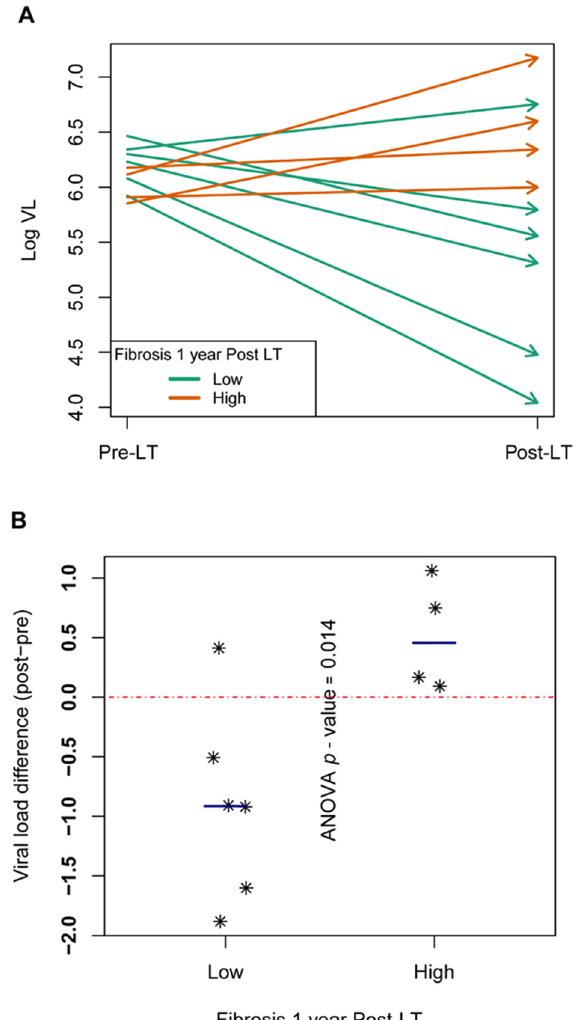
Figure 4. Viral load differences between pre and post-LT samples. ( A ) Arrows showing the evolution of log VL from pre-LT (arrow tails on the left) to 15-day post-LT (arrow heads on the right side of the box). At one year post-LT, patients with high fibrosis (F3–F4) in orange, patients with low fibrosis (F0–F2) in green. ( B ) Scatterplot with differences in log VL at 15 days post-LT minus pre-LT. The ANOVA p -value in the comparison of the two levels of liver damage is included. Each patient is represented as *.